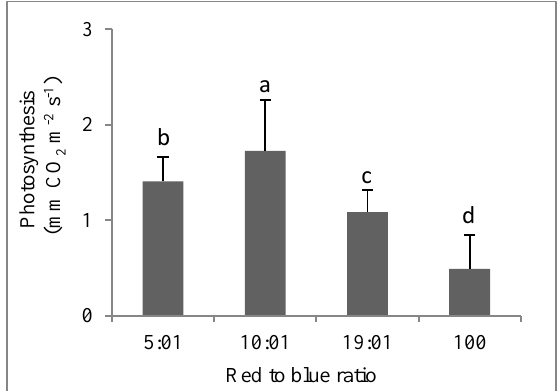
Figure 4. Photosynthesis of tomato plantlets under different ratios of red to blue led light. Mean separation within columns by Tukey’s HSD tests ( n = 5). Values labeled with different letters in a column are significantly different ( p < 0.05).